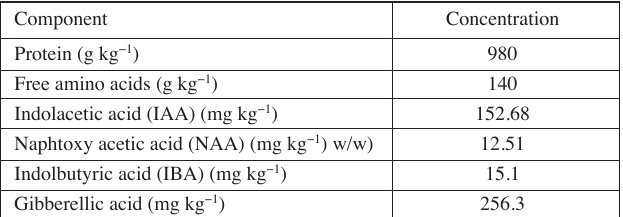
Tab. 1: Protein, amino acids and growth regulators content of AWE: means of three